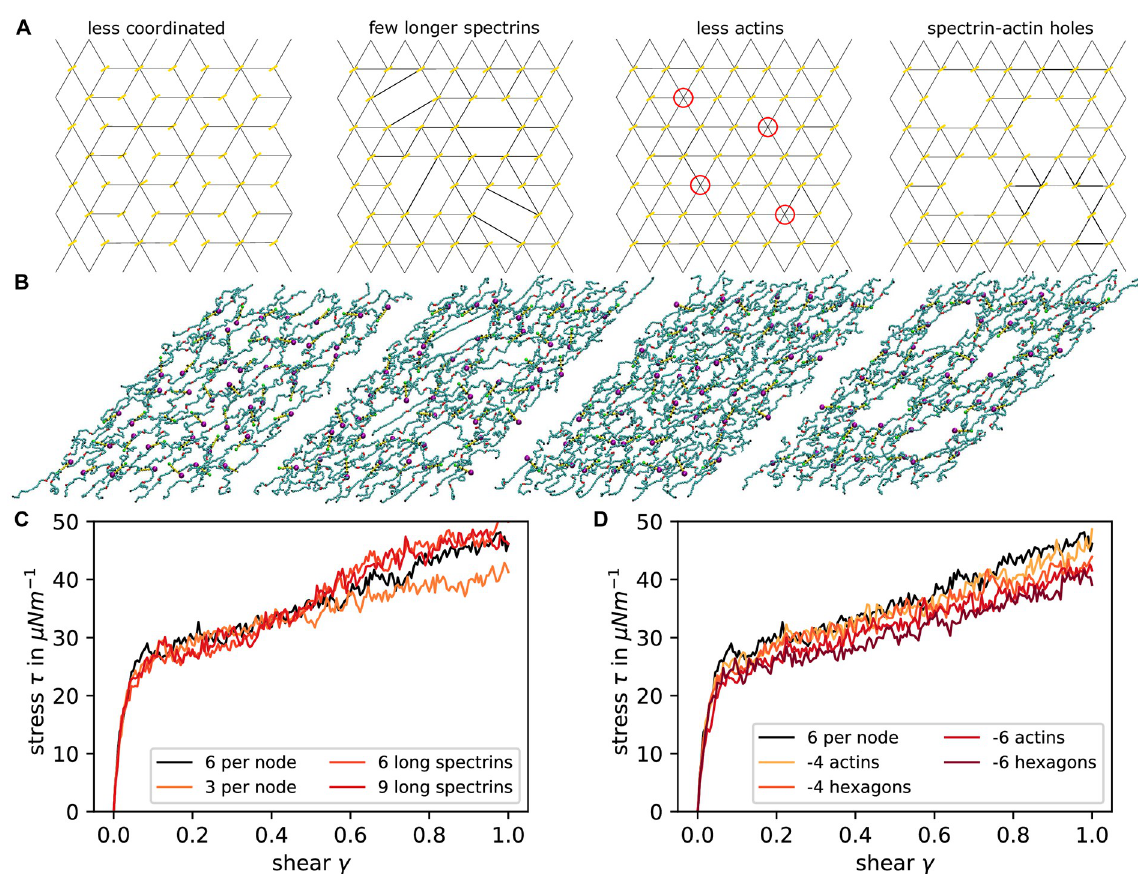
Fig 5. Effects of network connectivity on shear response. (A) Schematic representation for the network set-up. The yellow bars represent actin filaments and red circles indicate where an actin filament is missing. The black lines show the initialization positions of spectrin filaments. (B) Final configurations of the simulated networks at a shear of 1. The colors of the particles are the same as shown in Fig 2. (C) The stress-shear response is shown for networks with different connectivity. The black line corresponds to the perfect hexagonal network with six spectrins per node and the yellow line shows the response of a network with three spectrins per node. Additionally, some networks were simulated where four/six wholes where bridged with six/nine long spectrin filaments. (D) Here the effect of missing actins and spectrin filaments is analysed. Either only the actin nodes were taken away (-4/6 actins) or the whole hexagonal element including the spectrins (-4/6 hexagons). Again, this is compared to the perfect hexagonal lattice response in